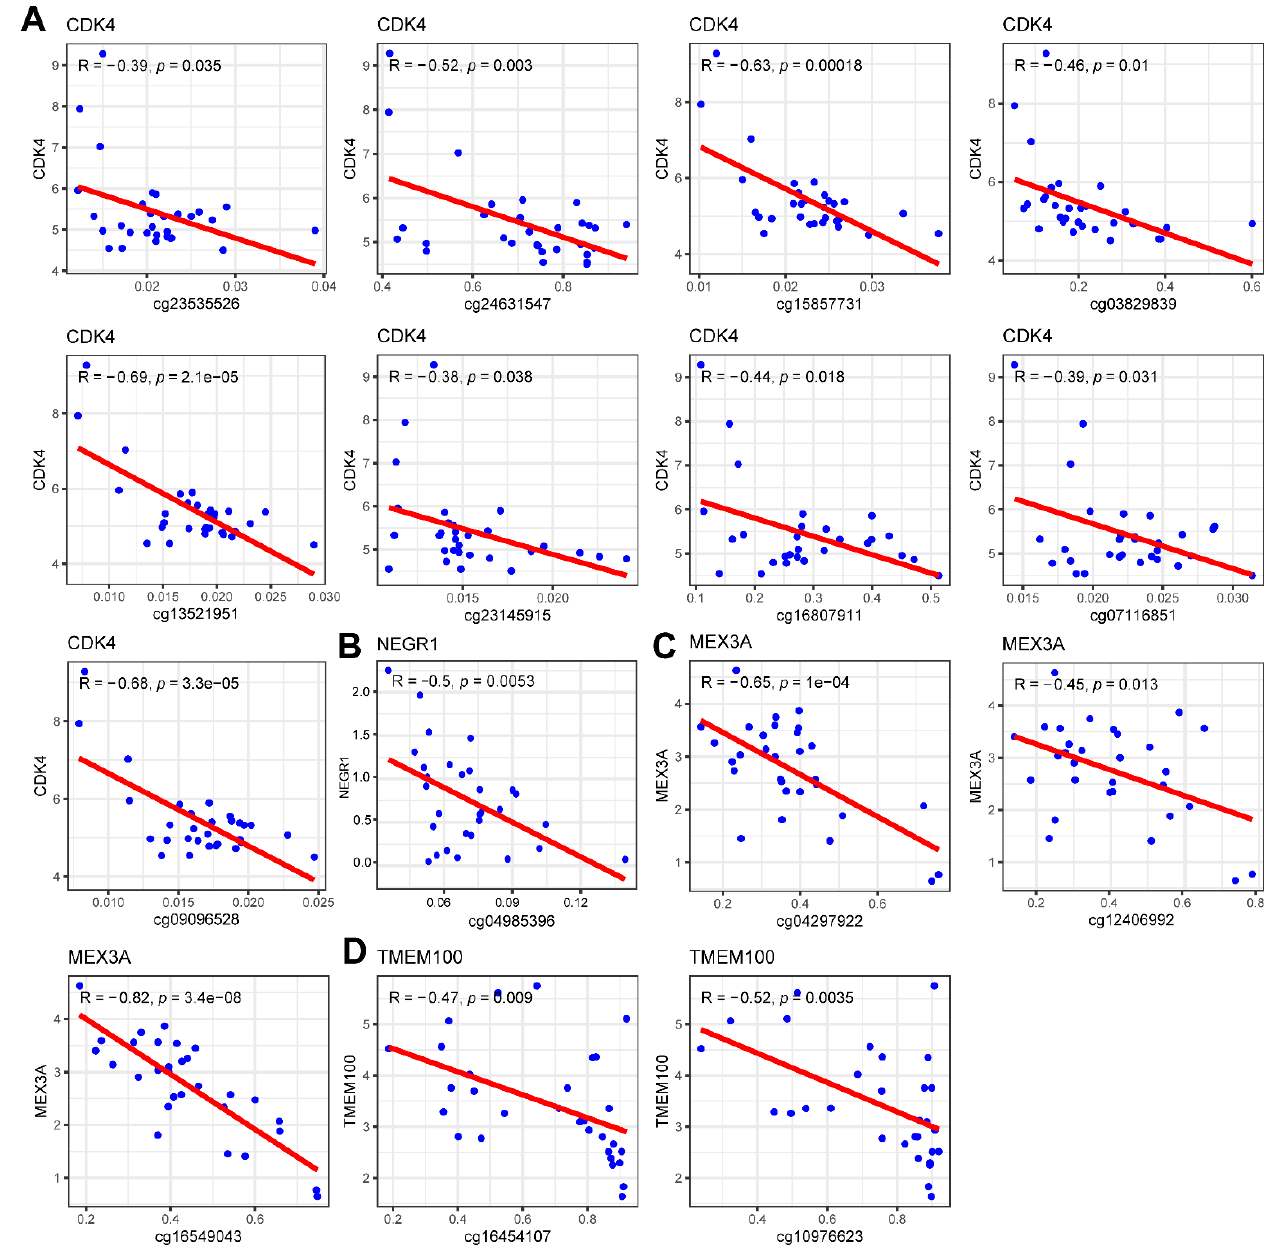
Figure 8. Correlation scatter plot of the significantly negative correlations between the expression of prognostic genes and different cg sites: ( A ) correlation scatter plot of CDK4 expression and its corresponding cg sites; ( B ) correlation scatter plot of NEGR1 expression and its corresponding cg sites; ( C ) correlation scatter plot of MEX3A expression and its corresponding cg sites; and ( D ) correlation scatter plot of TMEM100 expression and its corresponding cg sites.